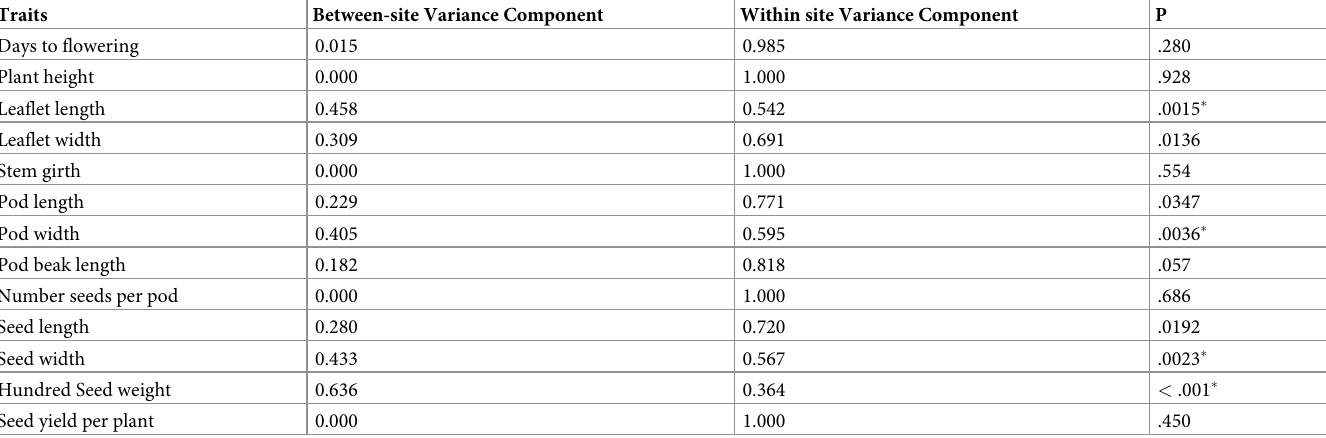
Table 6. Variance components (proportion of variance explained for the two different genetic clusters for 13 morphological